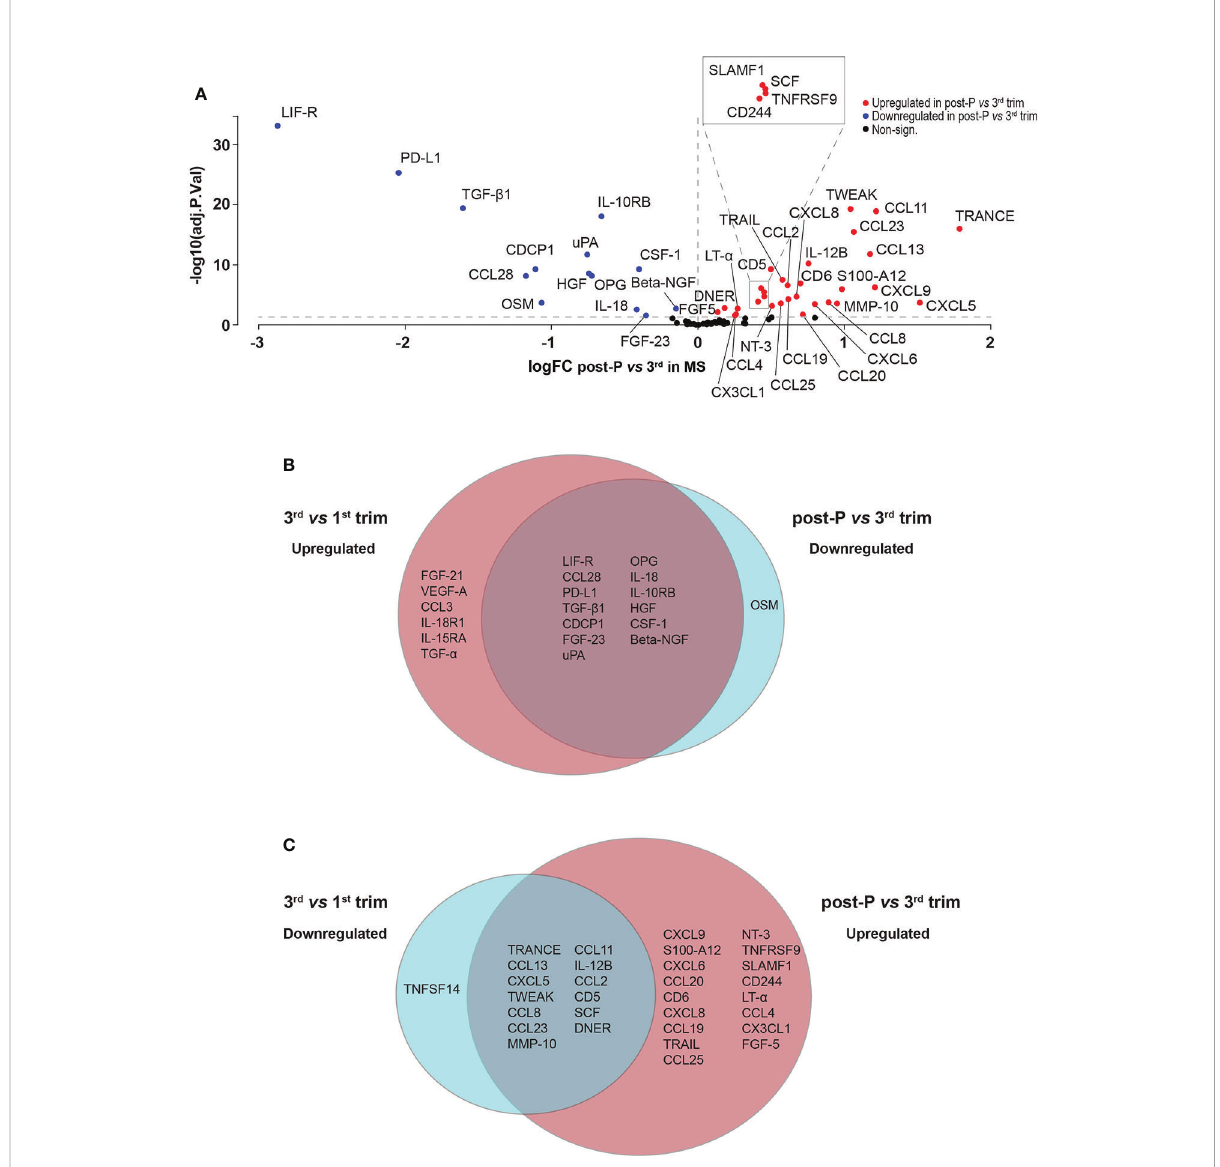
FIGURE 4 Differentially expressed proteins in post-partum versus 3 rd trimester in MS. (A) Volcano plot of the differentially expressed proteins (DEPs) at post-partum versus 3 rd trimester in MS patients (n = 15). DEPs were determined using linear models and Benjamini-Hochberg correction for multiple comparisons (FDR < 0.05). Up-and downregulated DEPs are shown as red and blue, respectively. Non-signi fi cant proteins are shown in black. (B, C) Venn diagrams depicting the common and unique DEPs comparing up- and downregulated DEPs in 3 rd versus 1 st trimester and post-partum versus 3 rd . logFC, logFoldChange; MS, multiple sclerosis; post-P, post-partum; trim,